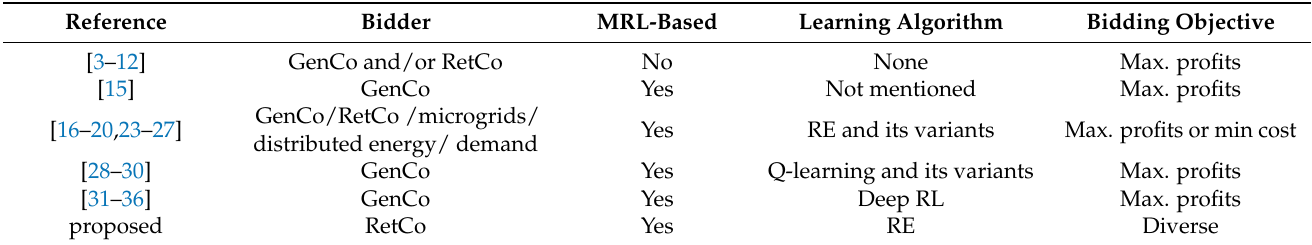
Table 1. Literature